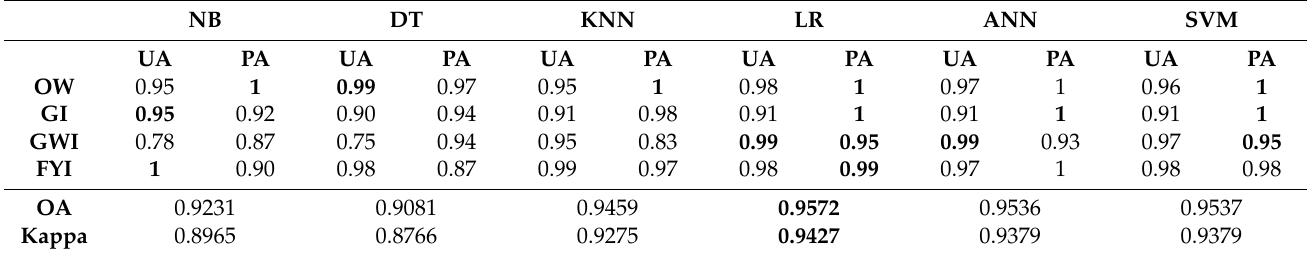
Table 5. User accuracy and producer accuracy of the base classifiers for each type of sea ice 1